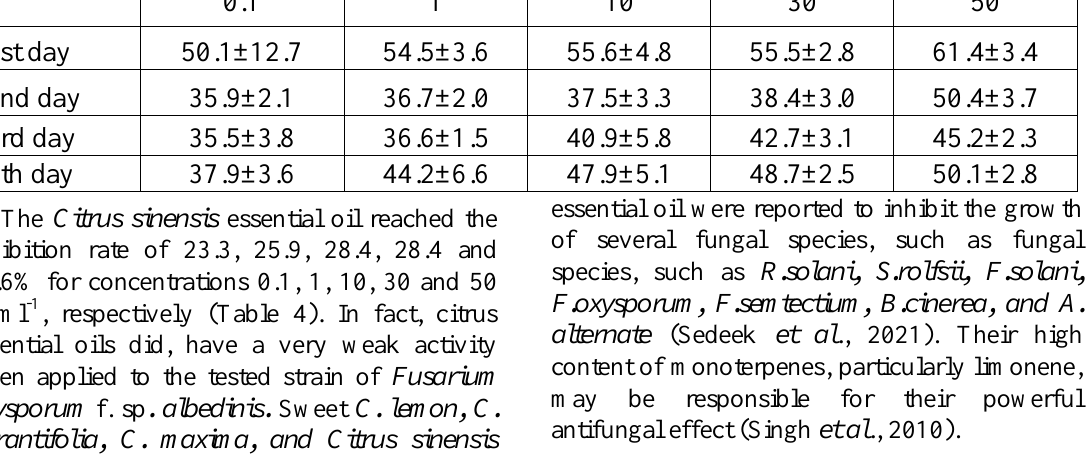
Table 4. Antifungal activity of Citrus sinensis essential oïl against fungal strain. Values are the